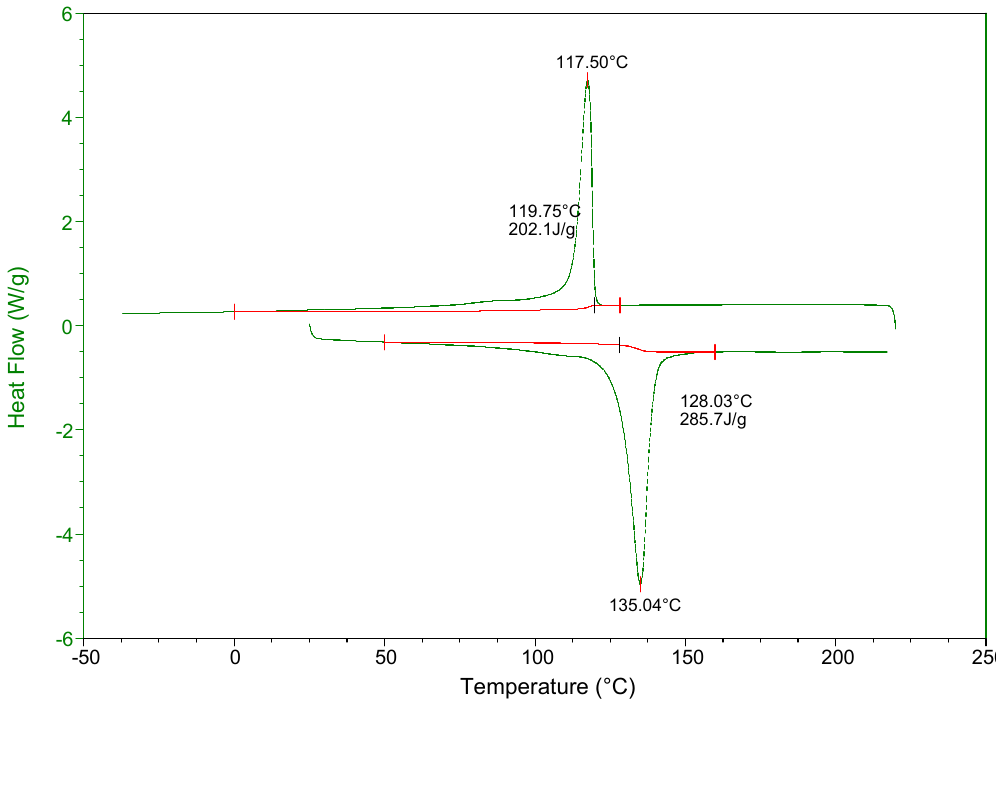
Figure 3. DSC profile of polyethylene sample produced by catalyst 1 (entry